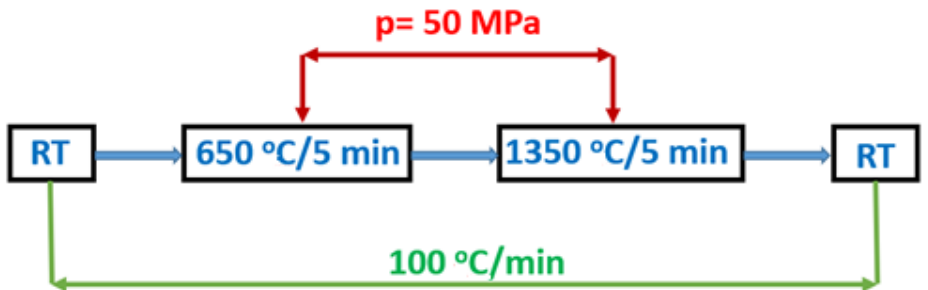
Figure 1. Diagram of SPS sintering thermomechanical schedule.